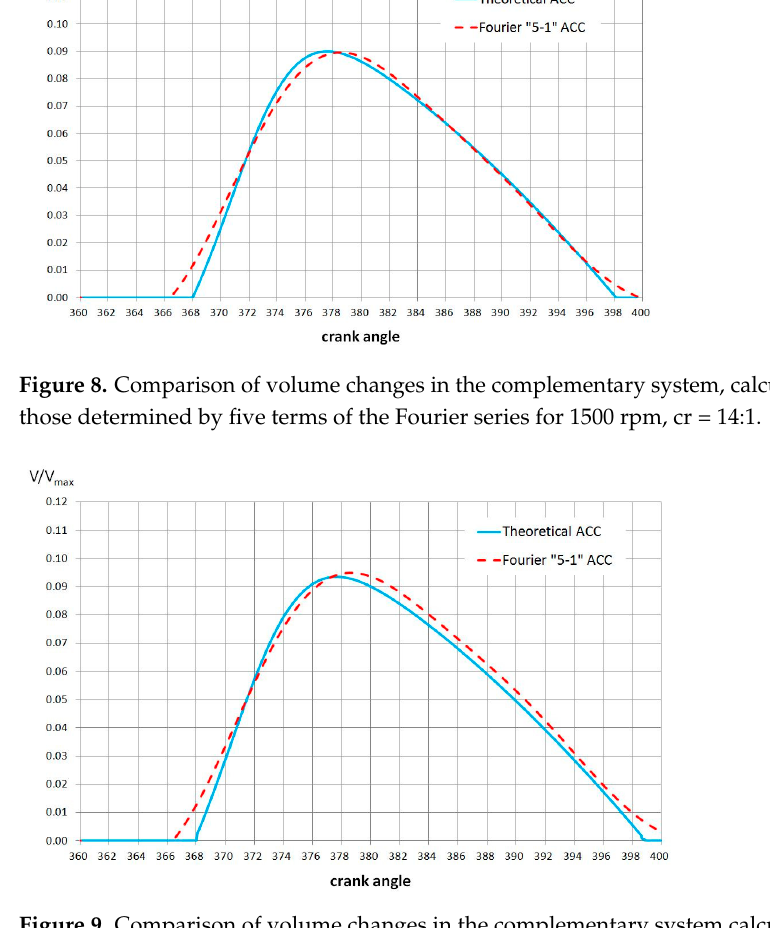
Figure 9. Comparison of volume changes in the complementary system calculated analytically with those determined by five terms of the Fourier series for 1500 rpm, cr = 17:1.